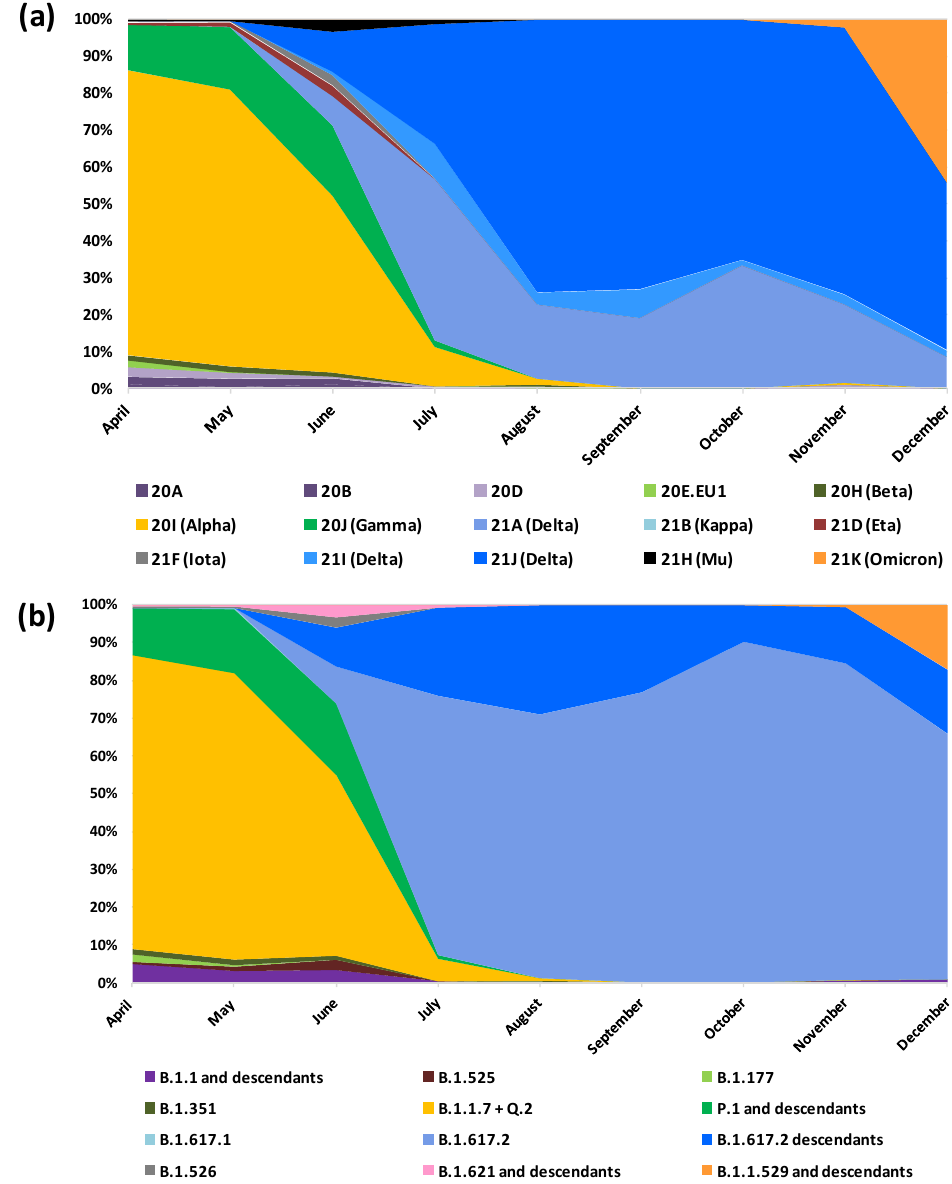
Figure 1. Dynamics of the SARS-CoV-2 epidemic in Italy. ( a ) Variant prevalence in terms of clades; ( b ) variant prevalence in terms of lineages.